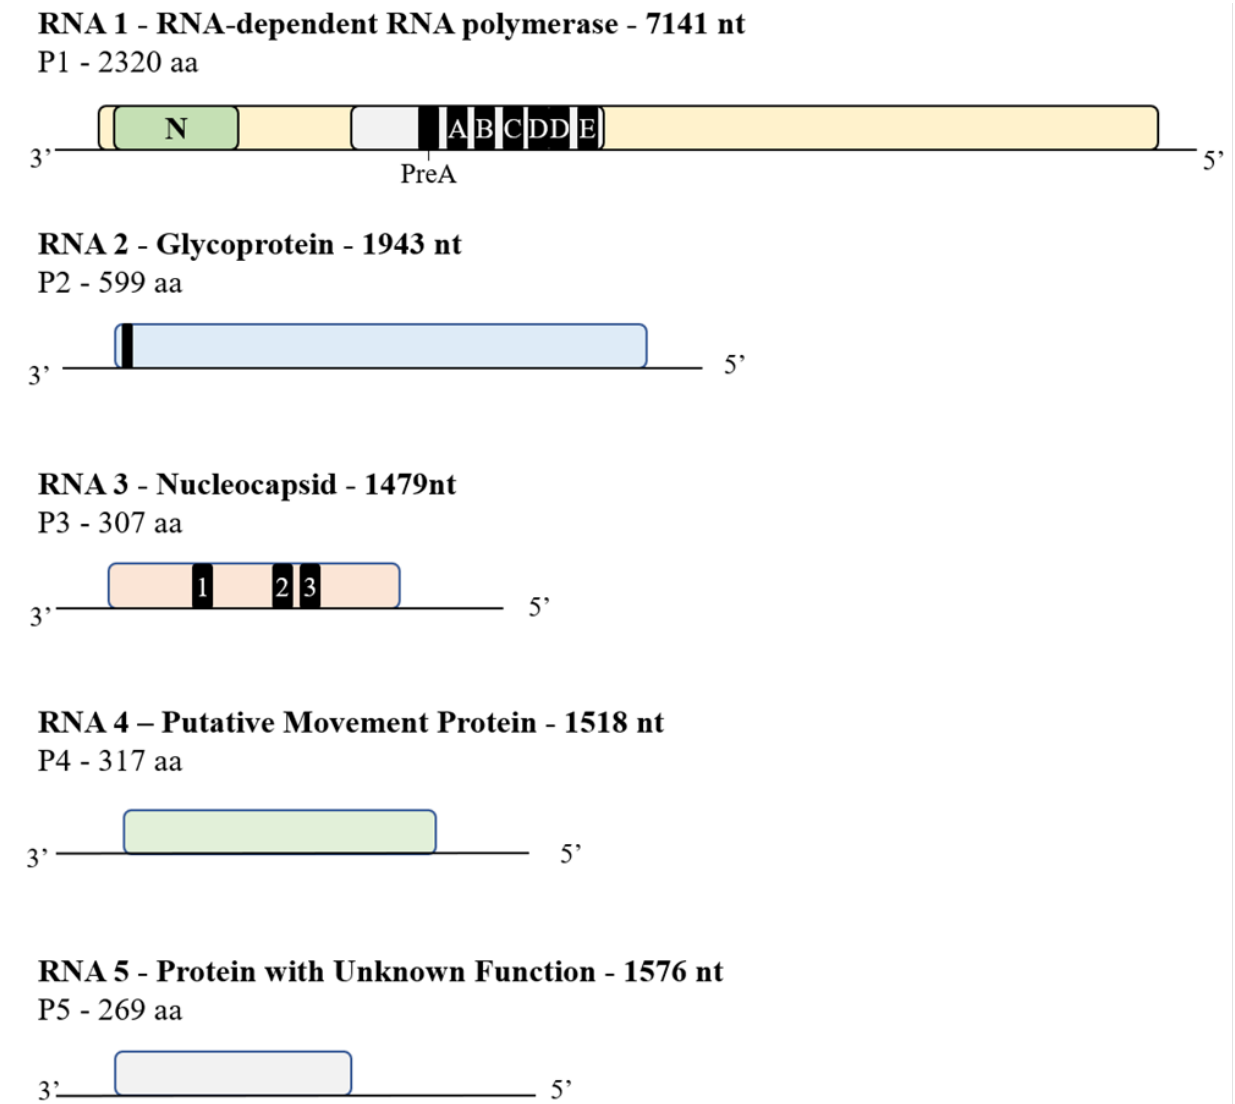
Figure 2. Genomic structure of the five negative-sense RNA segments identified for the KOPV genome. RNA 1: “N” is the putative N-terminus endonuclease domain and Pre-A, A, B, C, DD and E are emaravirus predicted RdRp motifs. RNA 2: black bar represents a putative signal peptide with cleavage site. RNA 3: 1, 2 and 3 represent conserved emaravirus motifs. Note: these segments are not to scale.